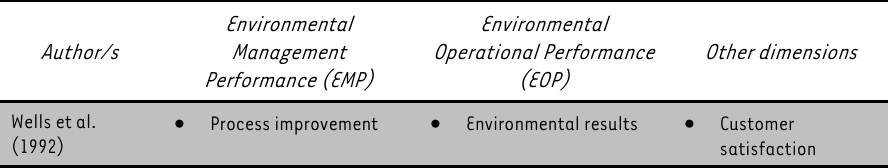
TABLE 1: Summarised Literature Review on Conceptualisation and Dimensions of